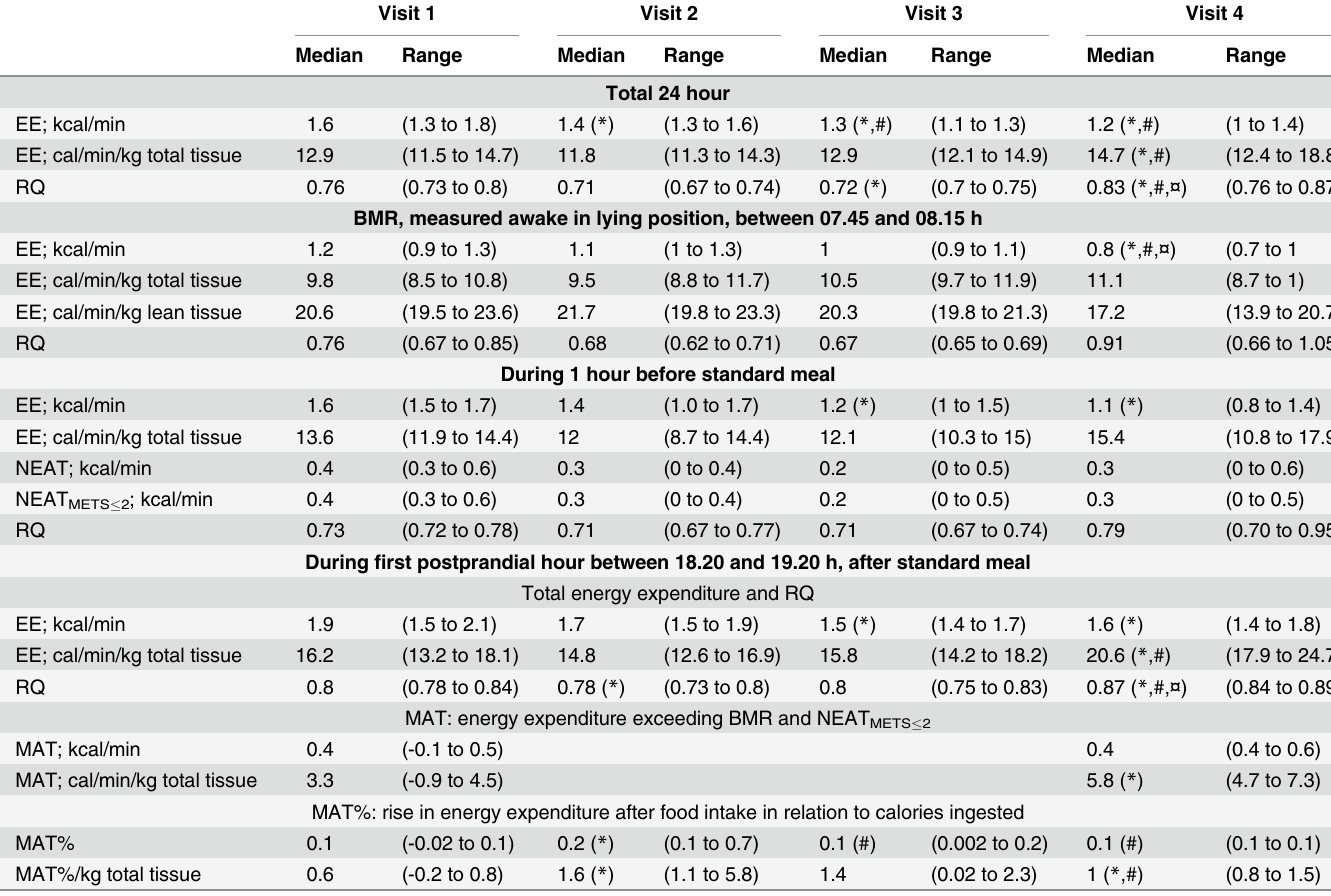
Table 3. Energy expenditure (EE) and respiratory quotient (RQ) in sex females before and after gastric bypass